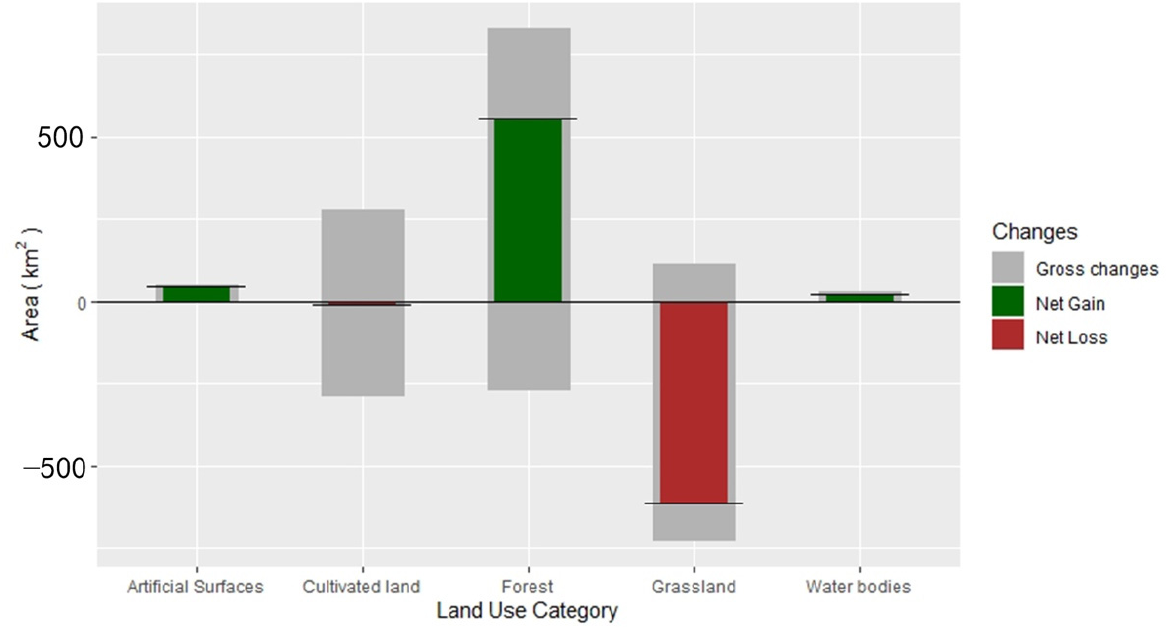
Table 3. Transition matrix of land ‐ use types in Enshi City from 2000 to 2020 (km 2 ).